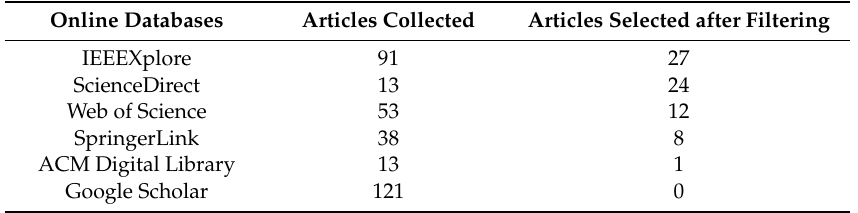
Table 4. Collected articles from di ff erent online databases.